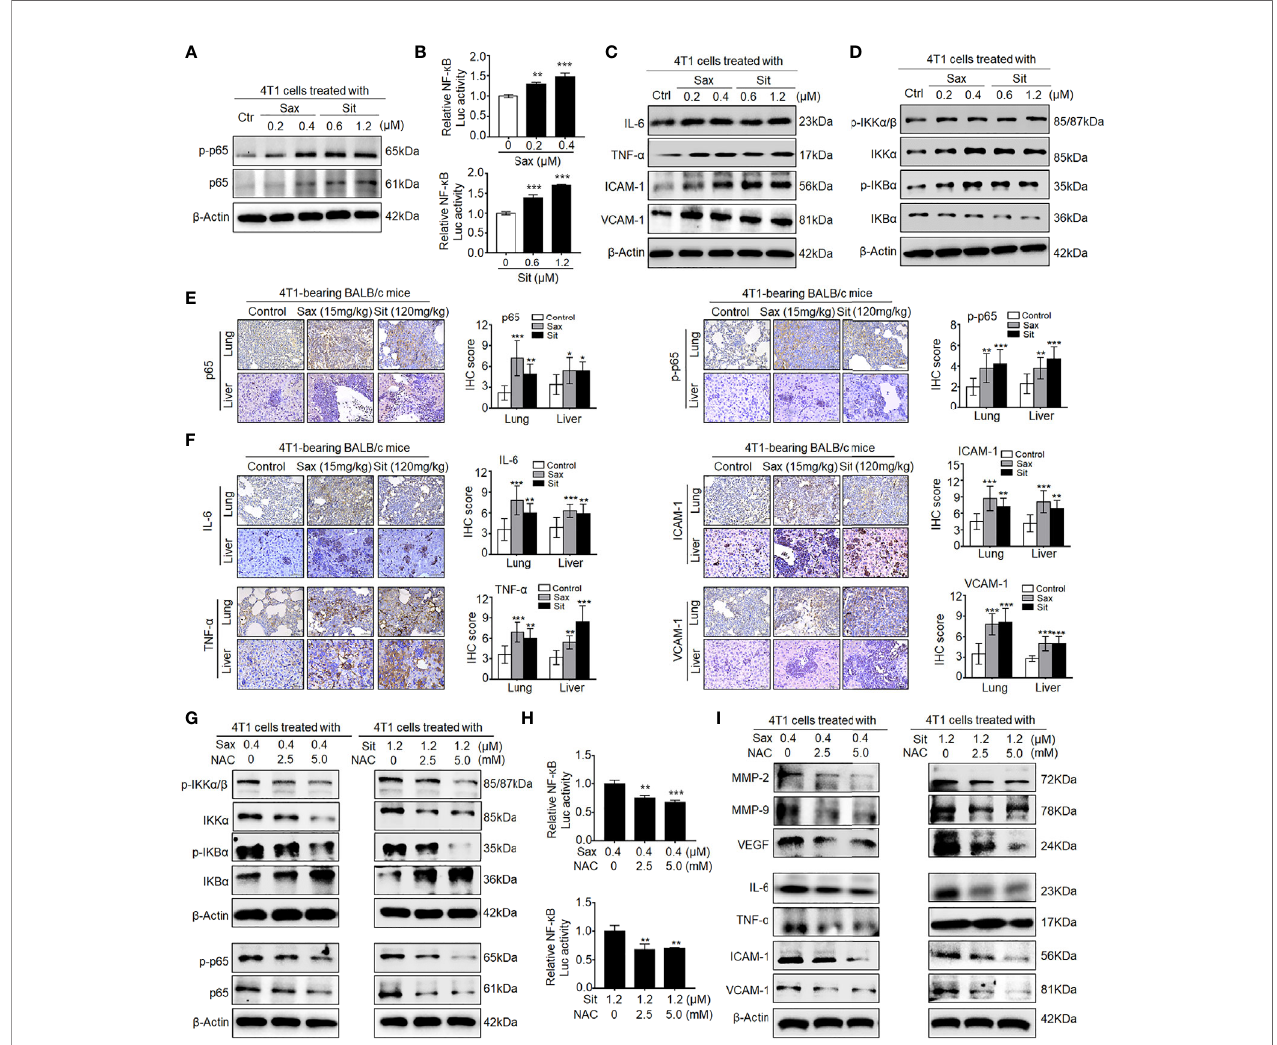
FIGURE 2 | DPP-4i triggers aberrant NF- к B activation via a ROS-dependent manner. (A – D) DPP-4i induces aberrant NF- к B activation of 4T1 cells in vitro . 4T1 cells were treated with Sax (0, 0.2, and 0.4 m M) or Sit (0, 0.6, and 1.2 m M) for 24 h. (A) Total p65, p-p65, (C) NF- к B-responsive proteins, and (D) p-IKK a / b , IKK a , p-IKB a , and IKB a levels were detected by Western blotting, and (B) NF- к B transcriptional activation was analyzed by luciferase reporter assay. (E, F) DPP-4i enhances aberrant NF- к B activation of 4T1 cells in vivo . 4T1-bearing BALB/c mice were treated with or without DPP-4i. (E) Total p65, p-p65, and (F) NF- к B- responsive proteins were detected in lung and liver metastatic tissues by IHC staining. (G – I) ROS scavenger abrogates DPP-4i-driven NF- к B activation in vitro . 4T1 cells were co-treated with Sax (0.4 m M) or Sit (1.2 m M) and NAC (0, 2.5, and 5 mM), respectively. (G) Total p65, p-p65, p-IKK a / b , IKK a , p-IKB a , and IKB a and (I) NF- к B-responsive proteins were detected by Western blotting. (H) NF- к B transcriptional activation was analyzed by luciferase reporter assay. b -Actin was as a loading control. Data are presented as mean ± SD of three independent experiments. Representative images are shown. Scale bars: 50 m m. *p < 0.05, **p < 0.01 and ***p < 0.001 between the indicated groups determined the one-way analysis of variance